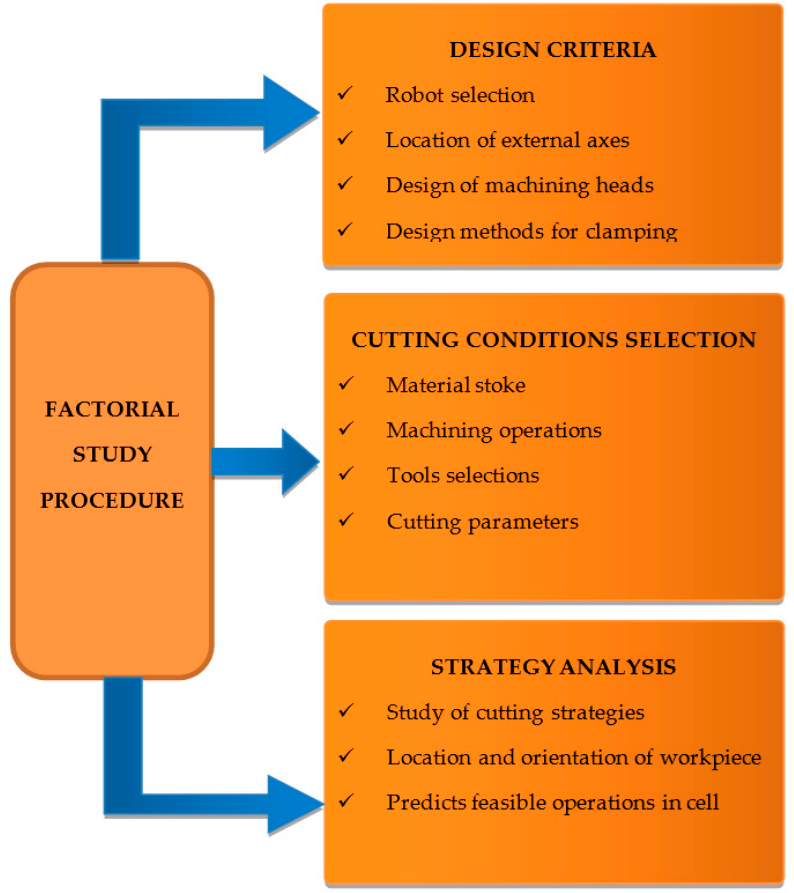
Figure 2. Decision-mapping diagram of the results of the factorial study procedure.